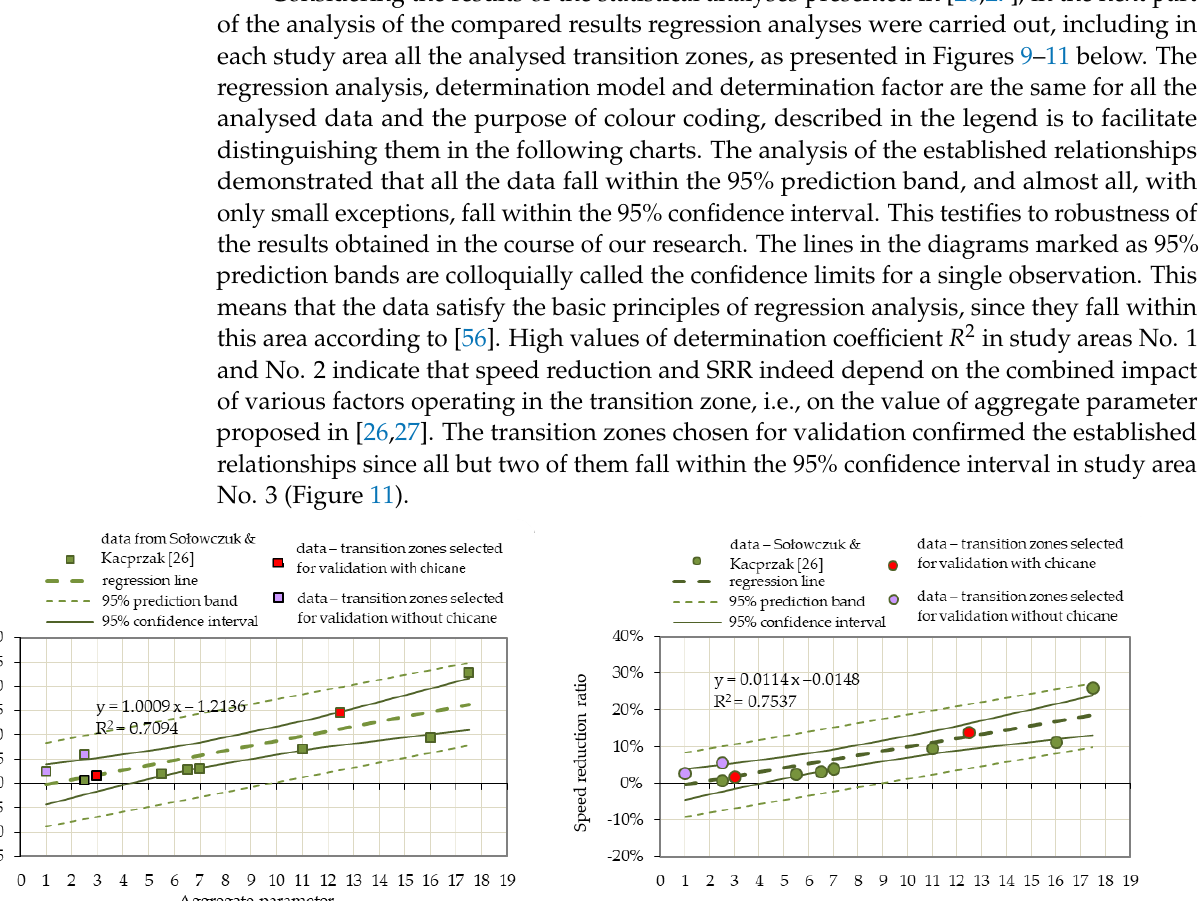
Figure 10. Linear regression function in the study area No. 2 defining the relationship between the aggregate parameter and speed reduction: ( a ) speed reduction ∆ v 85 ; ( b ) speed reduction ratio SRR. Source: own work of the authors.